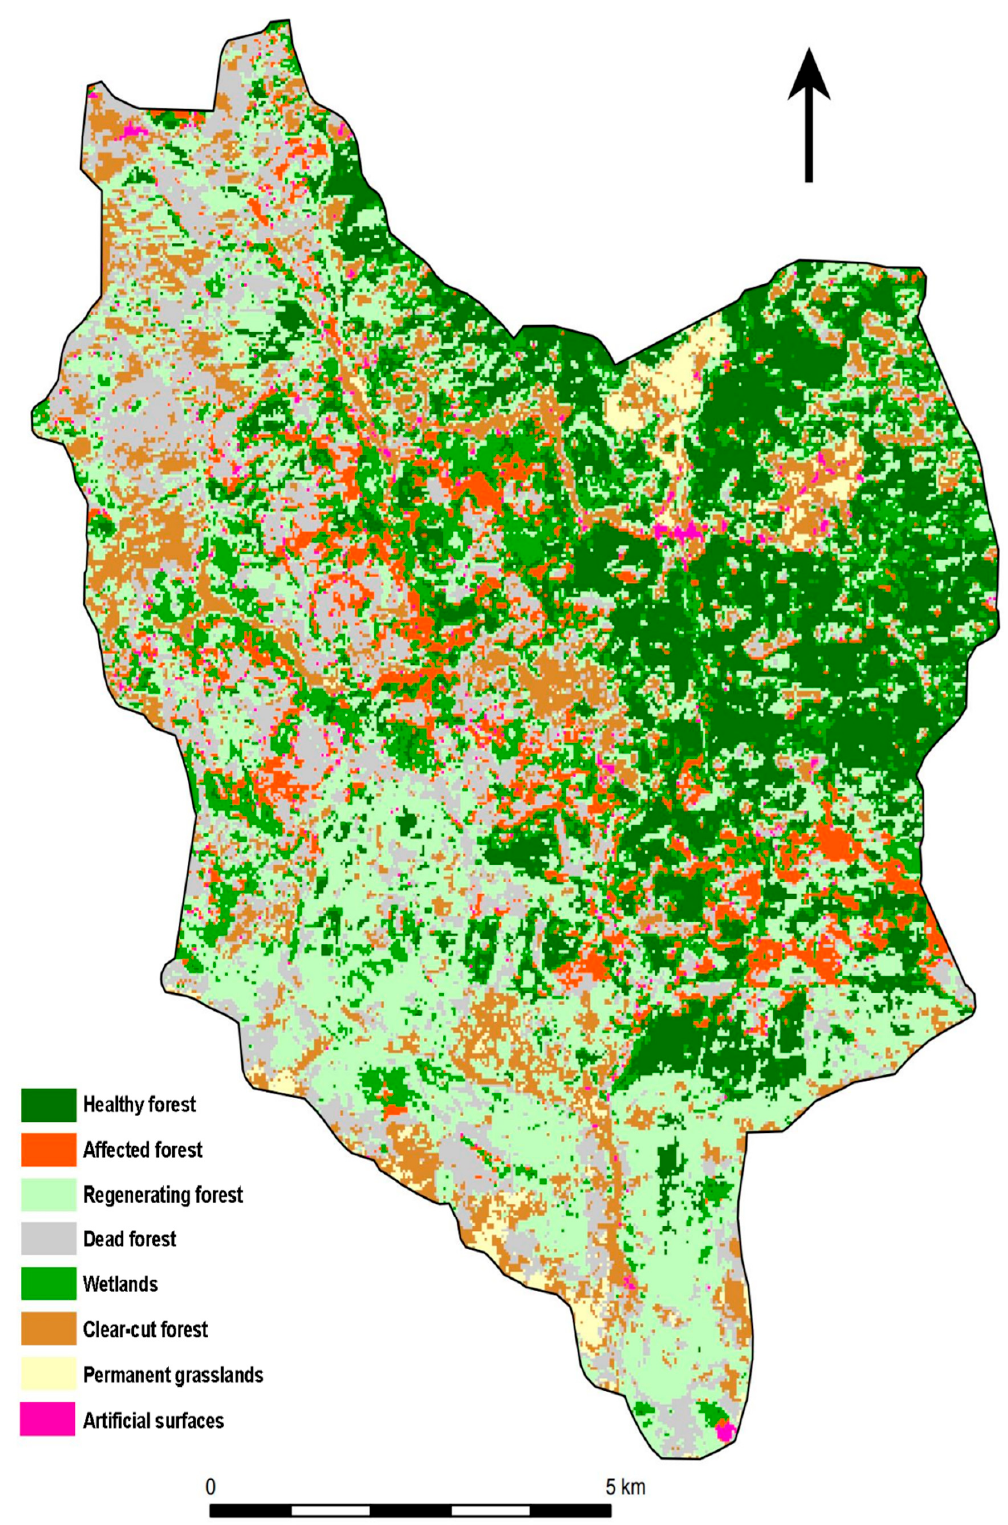
Figure A13. Classification NN, Landsat 8, 2016, NP Sumava.